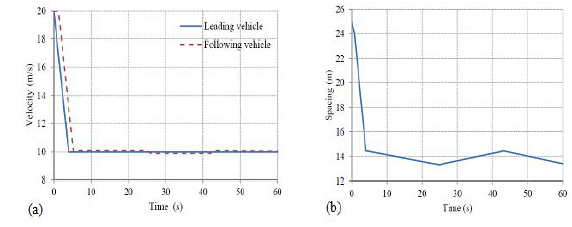
Fig. 4 Following speed and spacing with driving time while deceleration